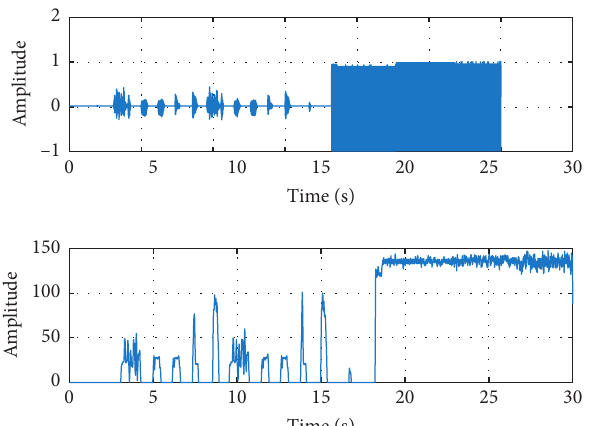
Figure 5: Time domain simulation of music signal feedback model.